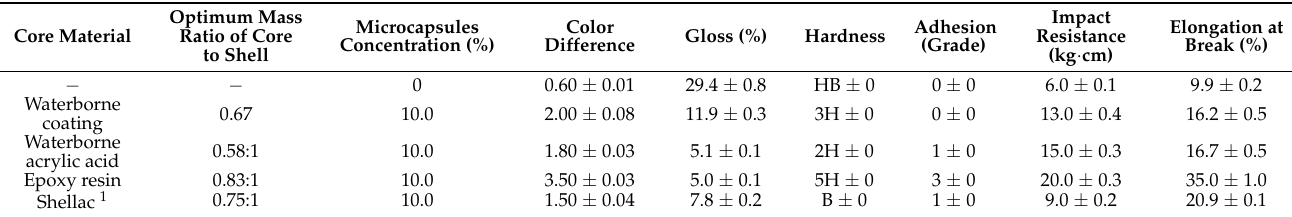
Table 10. Performance comparison of waterborne coatings with different microcapsules.